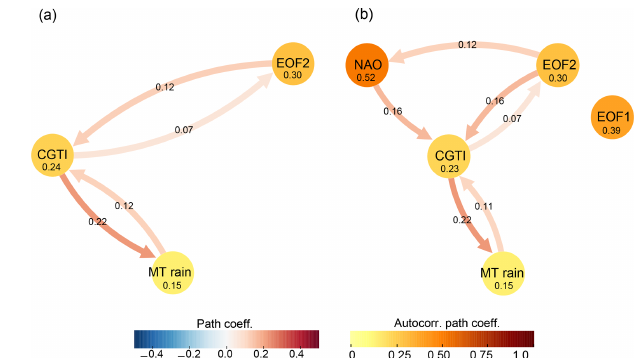
Figure 3. Causal mid-latitude interactions with the ISM. (a) Causal effect network (CEN) built with CGTI, the principal component of EOF2 and MT rainfall for the period 1979–2017. (b) Same as panel (a) but with the addition of the principal component of EOF1 and NAO. The strength of the causal links expressed by the stan- dardized regression path coefficients and autocorrelation path coef- ficients is shown over the arrows and inside the circles, respectively. All links have a lag of 1 week. Only causal links with corrected p < 0 . 05 are shown. See the main text for